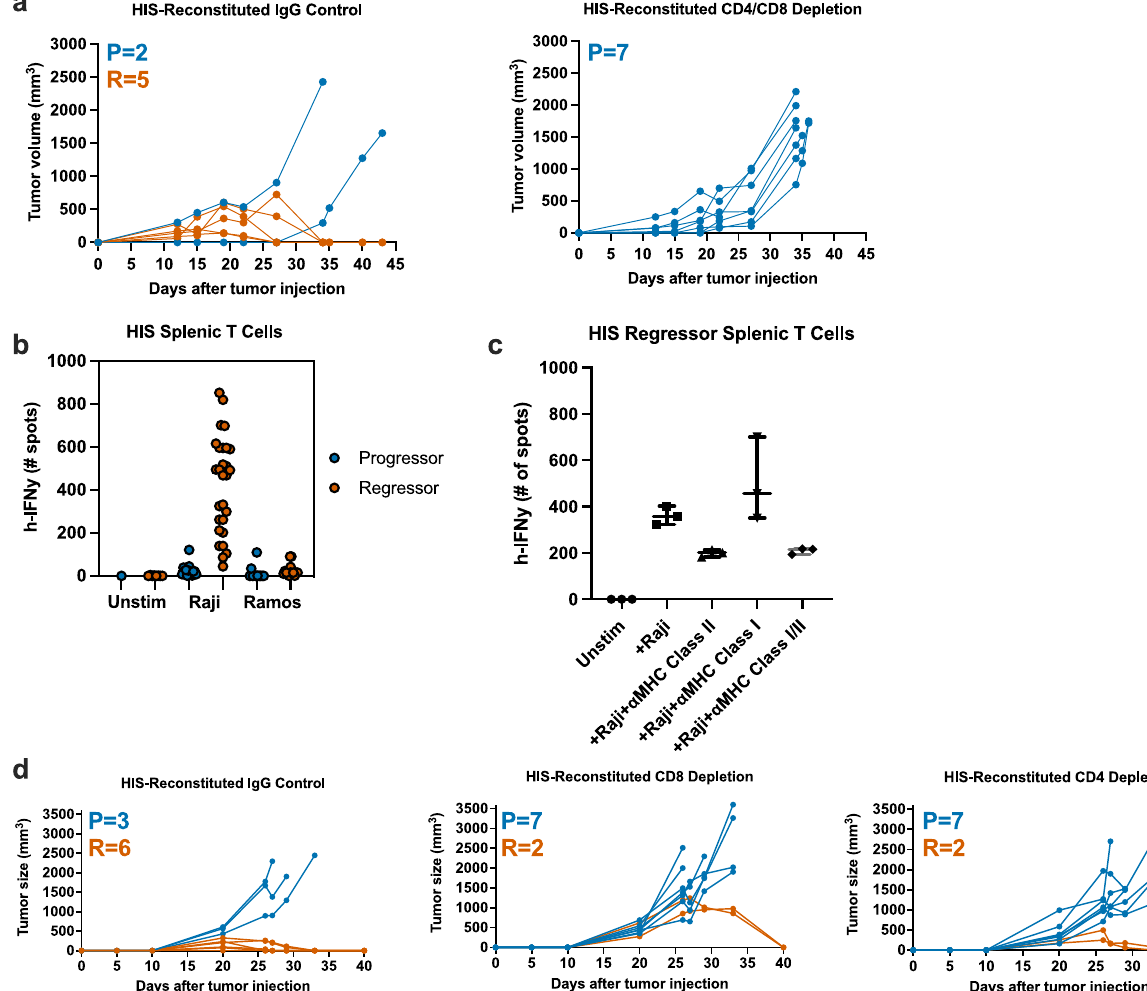
Fig. 2 Raji tumor control is T-cell-mediated. a Tumor growth curve of mice in the control group ( n = 7 isotype) compared to CD8-depleted and CD4- depleted ( n = 7 anti-CD4/anti-CD8). b ELISpot data comparing human immune system (HIS) splenic T cells from progressor and regressor mice ( n = 67). HIS splenic T cells were co-cultured alone (unstimulated), with Raji or with Ramos. c ELISpot data of HIS splenic T cells isolated from mouse with Raji regression. T cells were co-cultured alone (unstimulated) or with Raji alone, Raj i + anti-MHC class II blocking, Raji + anti-MHC class I blocking antibody, and Raji + both anti-MHC class 1/class 2 blocking antibodies. d Tumor growth curve of mice in the control group ( n = 7 isotype), versus CD8-depleted ( n = 7 anti-CD8) and compared to CD4-depleted ( n = 7 anti-CD4). The number of mice with tumor progression (P; orange) or regressor (R; blue) is shown. Antibody treatments started 2 days before tumor implantation. Mean value with SD are indicated. Error bars are equivalent